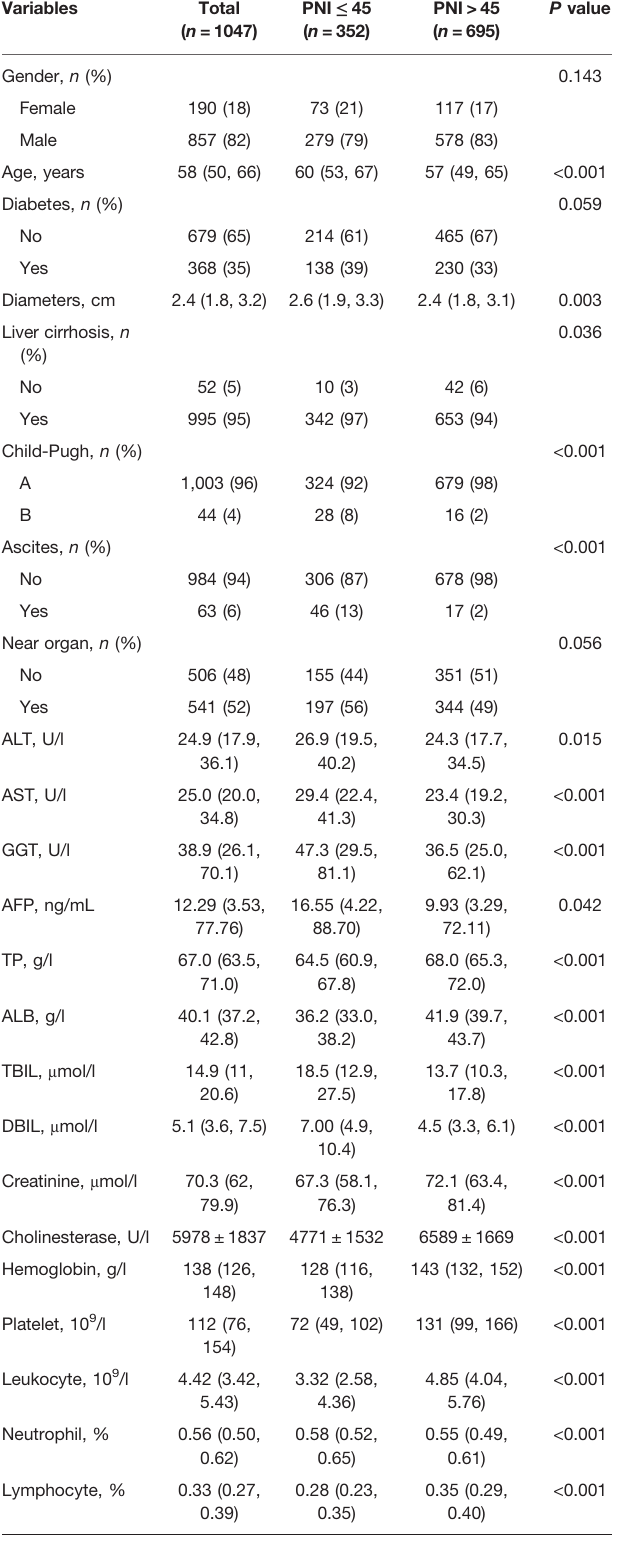
TABLE 1 | The relationship between clinicopathological factors and PNI in HCC patients with HBV infection following US-PMWA.